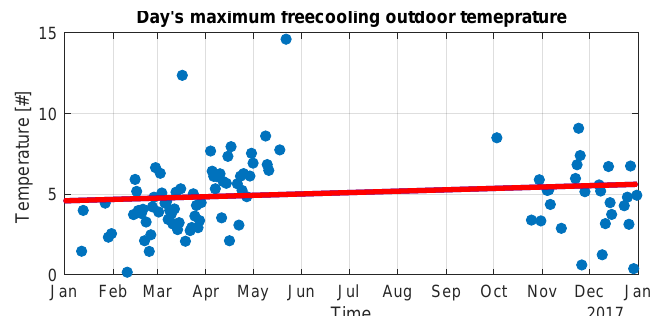
Figure 23. Maximum outside temperatures in freecooling mode—BREF system.